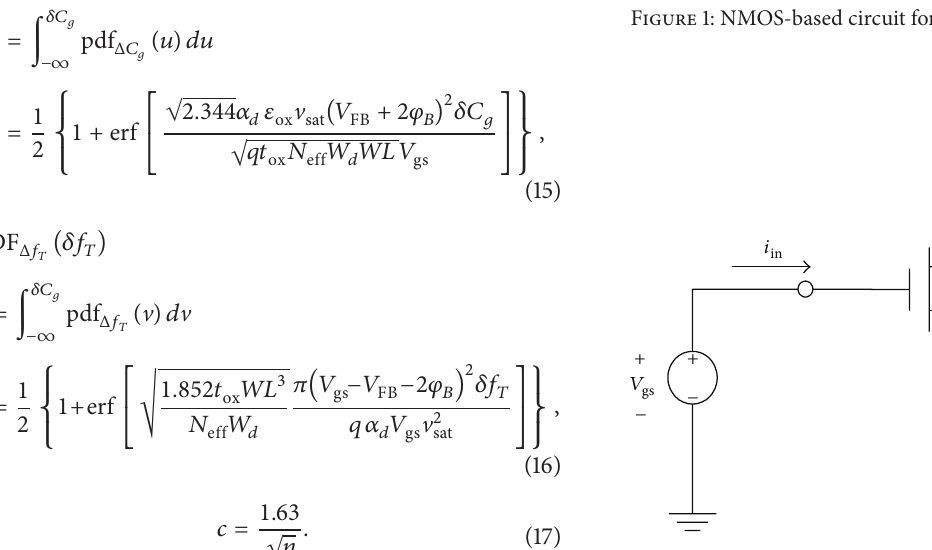
Figure 1: NMOS-based circuit for verifying pdf Δ𝐶